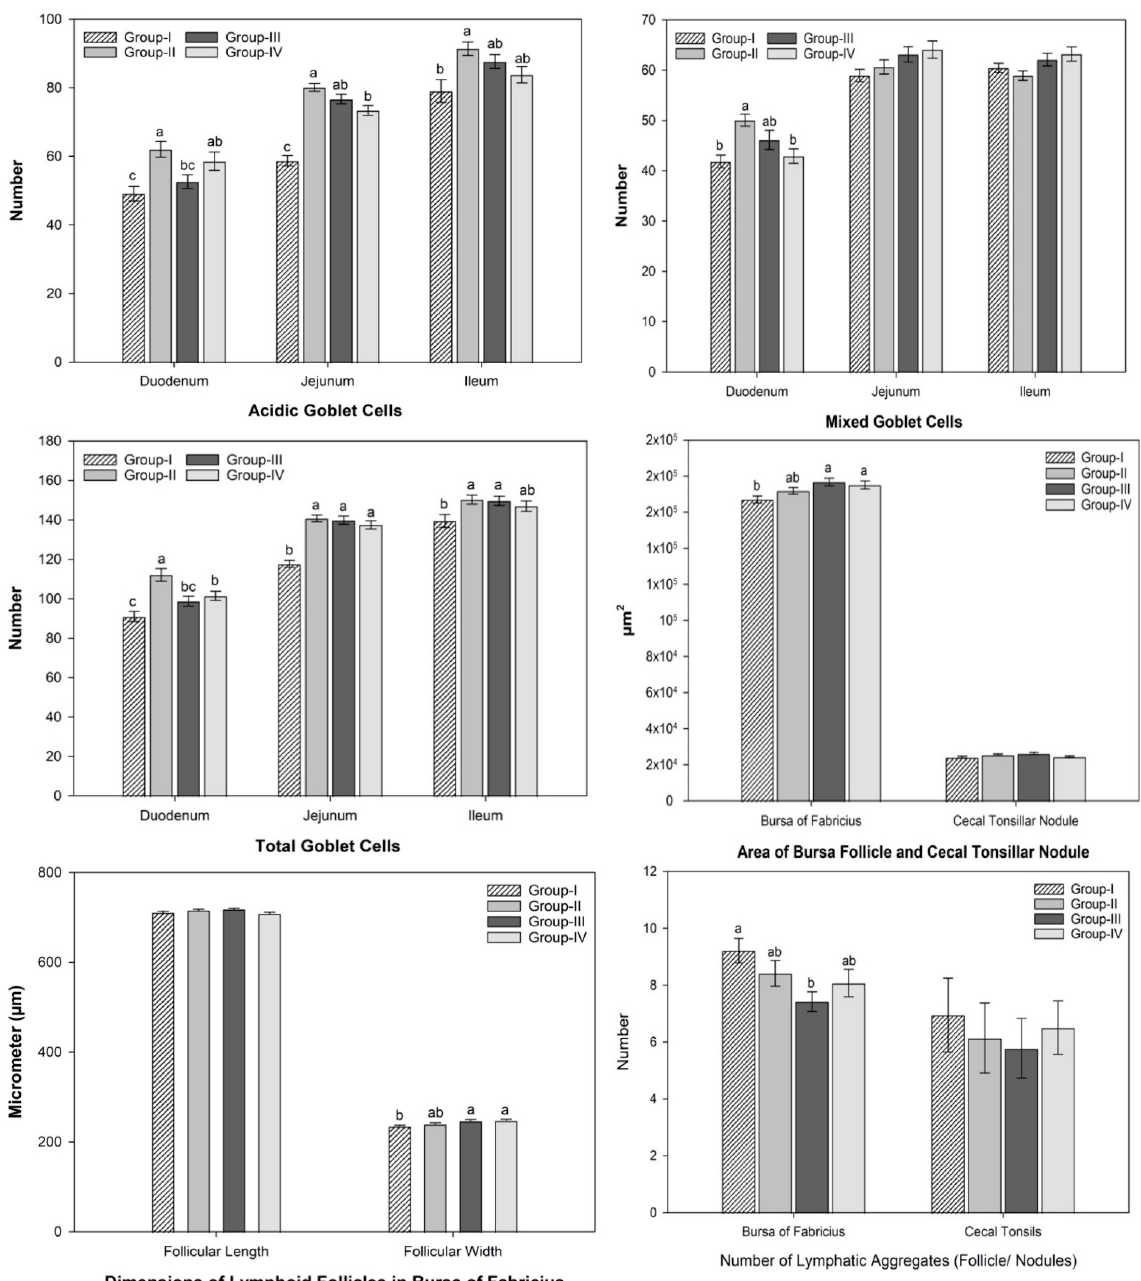
Figure 2. Graphical representation of the histomorphometry of immune organs and cells in broilers. Different superscripts ( a,b,c ) correspond to varying levels of significance between groups.